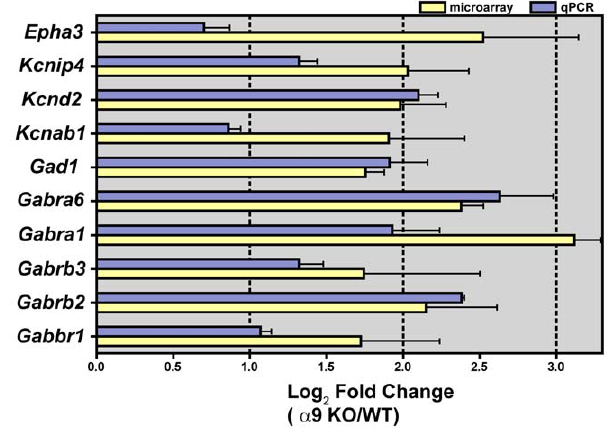
Figure 3. Confirmation of selected genes at the transcript level. ( A ) Log 2 fold changes in expression levels of selected transcripts measured by qPCR are plotted alongside their fold changes obtained by microarray analysis. For the ten selected genes, expression values from microarray and qPCR showed similar relative changes ( p , 0.05, two- tailed t -test). Error bars indicate SEM.